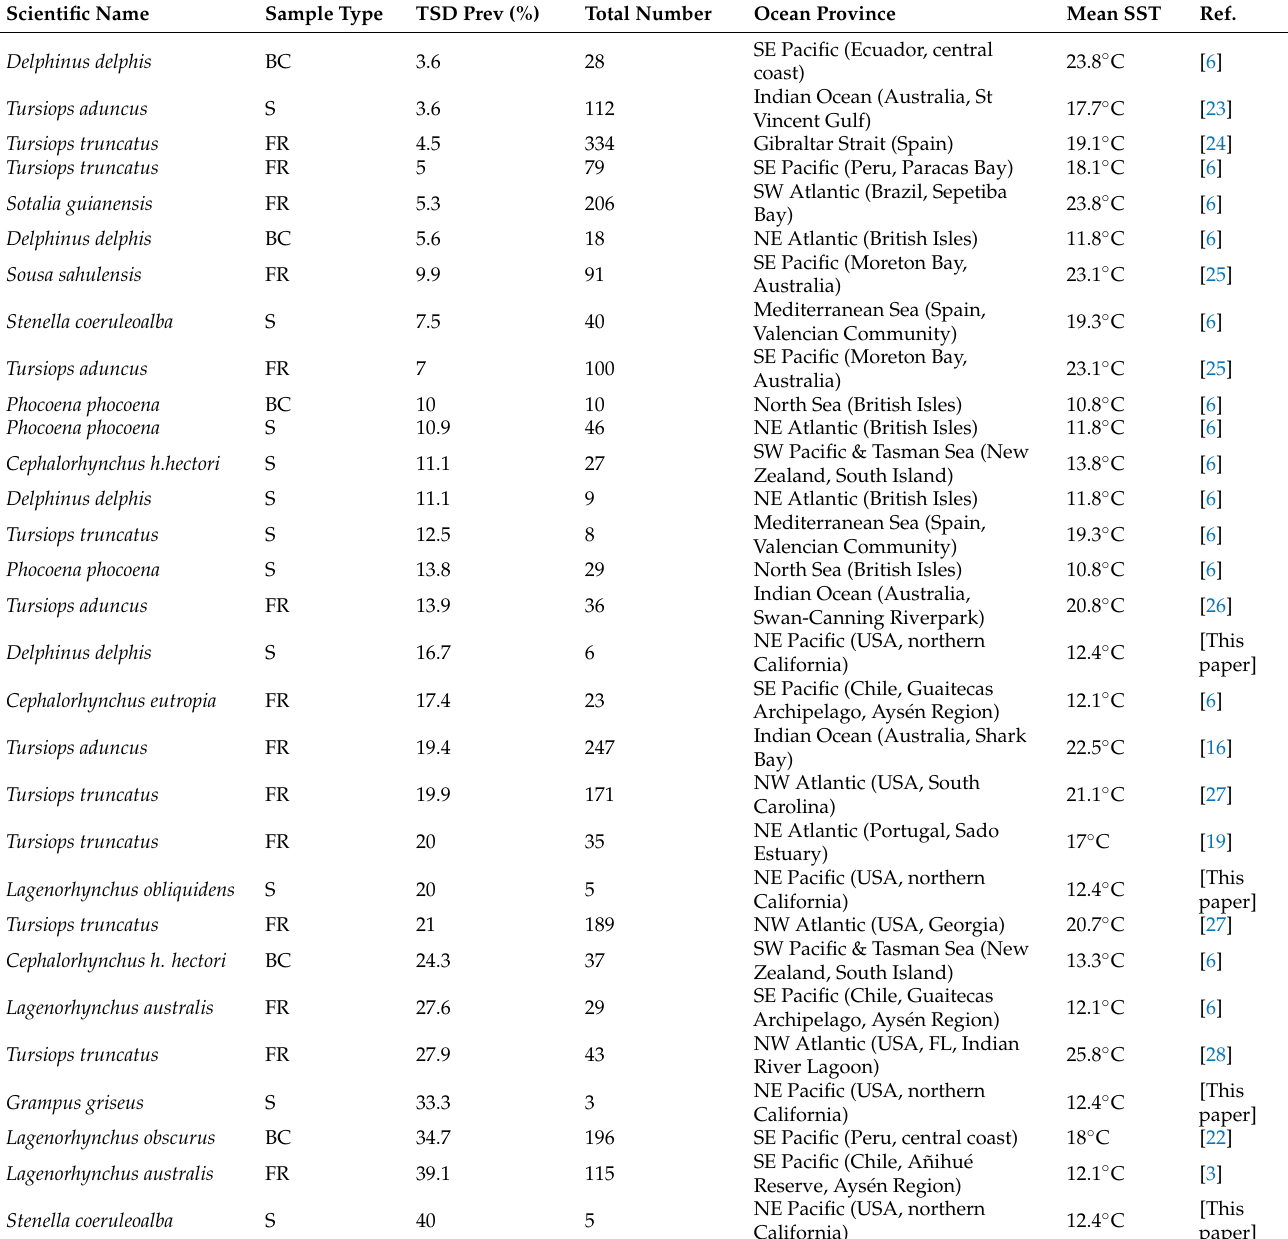
Table 1. Occurrence and prevalence levels (Prev) of tattoo skin disease (TSD) in free-ranging (FR), by-caught (BC), hunted (H) and stranded (S) odontocetes and mysticetes worldwide. Mean sea surface temperature (SST) is provided [https://www.seatemperature.org/, accessed on 18 November 2022)]; NA = not available; () = number of positive individuals; Ref =